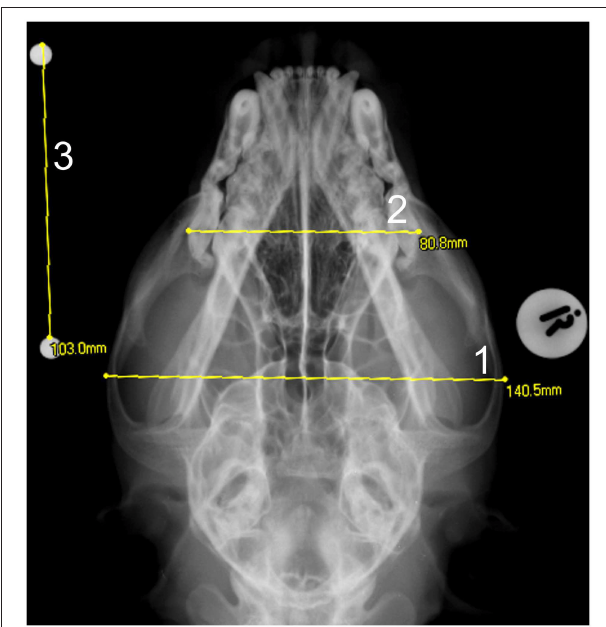
FIGURE 4 | A dorso-ventral skull radiograph of a cheetah cub showing the measurement of the: 1- maximum skull width and 2- the maximum maxilla width. A 100mm scale bar was placed at a height equal to the middle of the skull in order to quantify the enlargement factor -3.